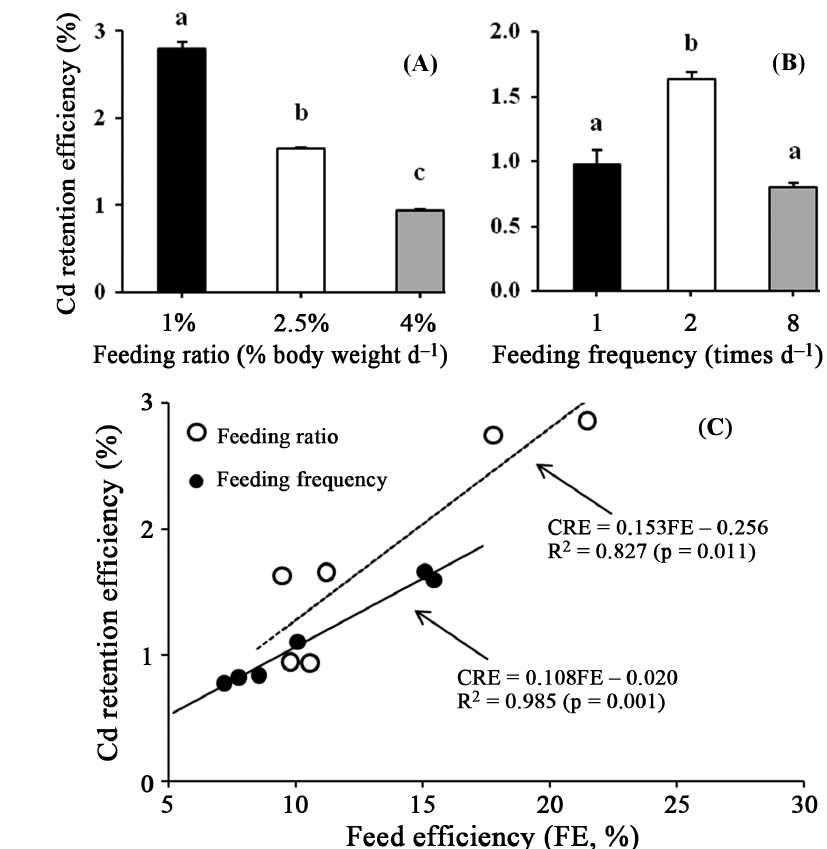
Fig. 5. (A,B) Cadmium retention efficiency (CRE, %) and (C) correlation be- tween feed efficiency (FE, %) and CRE in black sea bream Acanthopagrus schlegeli exposed to dietary Cd (254.4 µg g –1 ) for 5 wk at different feeding ratios (FR) or frequencies (FF). (A) CRE of fish fed at 3 different FR of 1, 2.5 and